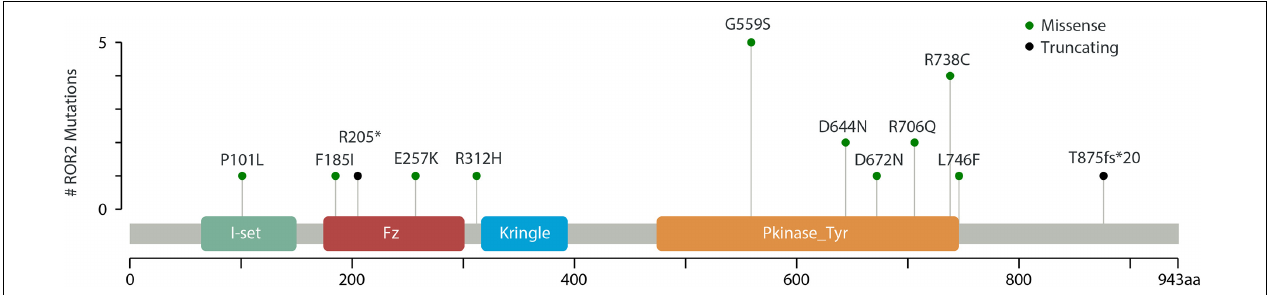
FIGURE 2 | Schematic representation of ROR2 with its domain structure. Mutations identified in this study (green and black) are marked.